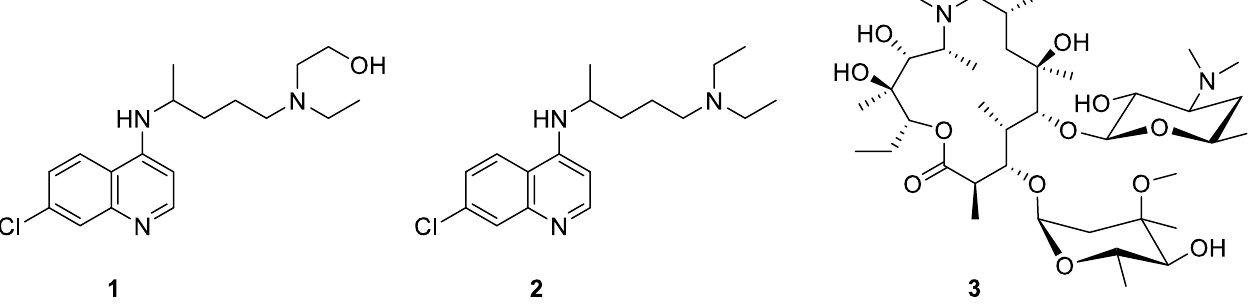
Figure 1. Chemical structure of hydroxychloroquine ( 1 ), chloroquine ( 2 ), and azithromycin ( 3 ). The modes of action of hydroxychloroquine in the treatment of COVID-19 appear to be complex and diverse, going from inhibition of the binding between the S protein and ACE2 to repression of activation of cytokines further to an increase in the pH of endosomes and lysosomes [20 – 22].